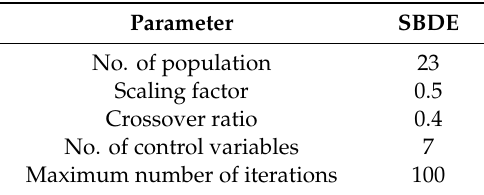
Table 2. Simulation